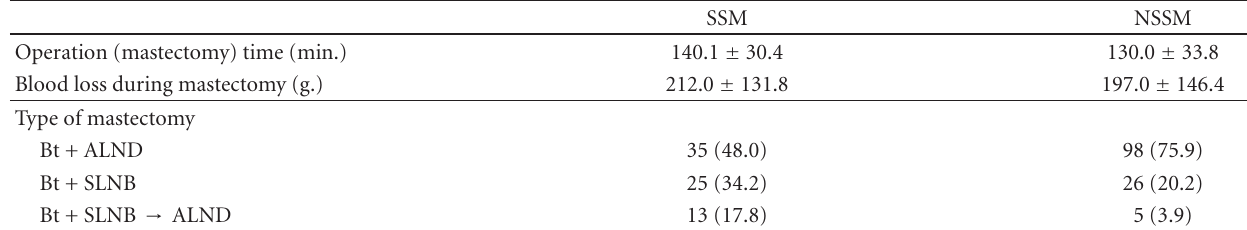
Table 2: Operation characteristics in SSM and NSSM (%).